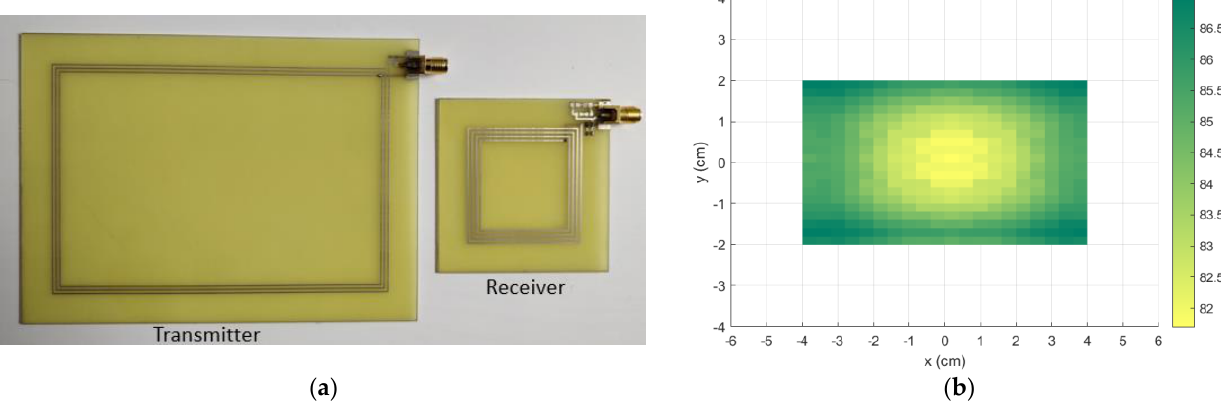
Figure 7. ( a ) 3D Model representing the optimized coils and the representation of the charging surface; ( b ) electromagnetic simulation results of the efficiency (%) of the optimized coils.